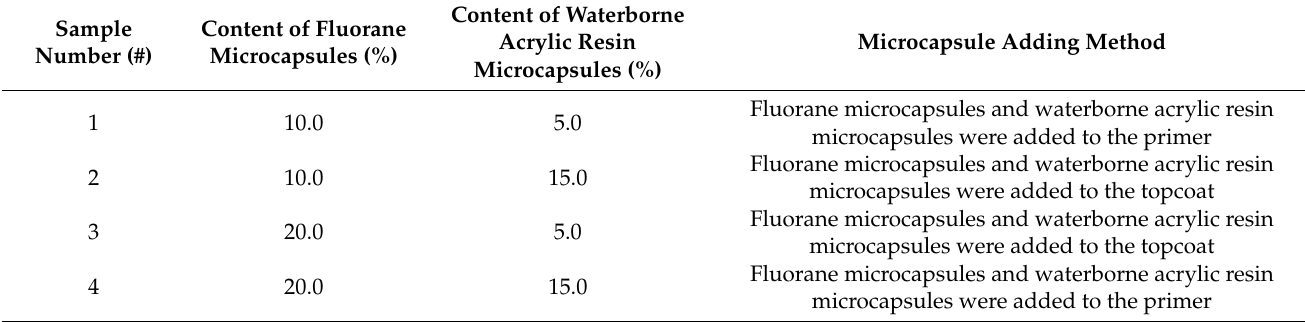
Table 1. Orthogonal experiment design of thermochromic self-repairing coating film.